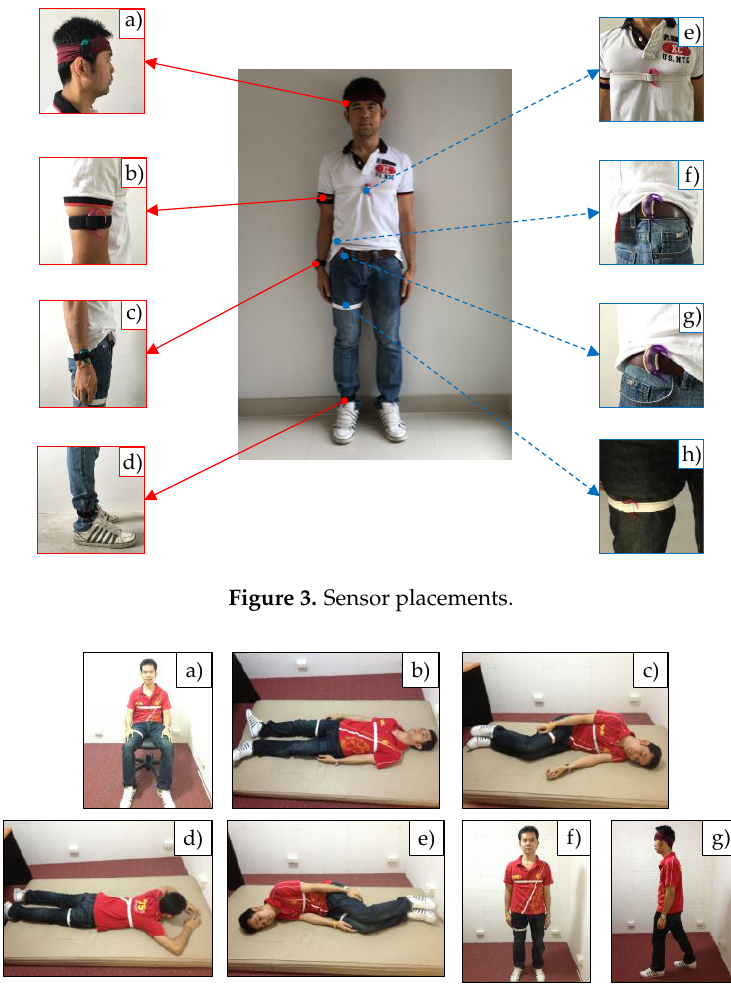
Figure 4. A young subject performing a sequence of seven activities.